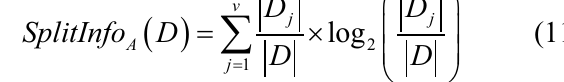
This value represents the potential information generated by splitting the training data set, D, into v partitions, corresponding to the v outcomes of test on attribute A. For each outcome, it considers the number of tuples having the outcome with respect to the total number of tuples in D. The gain ratio is defined as in Equation